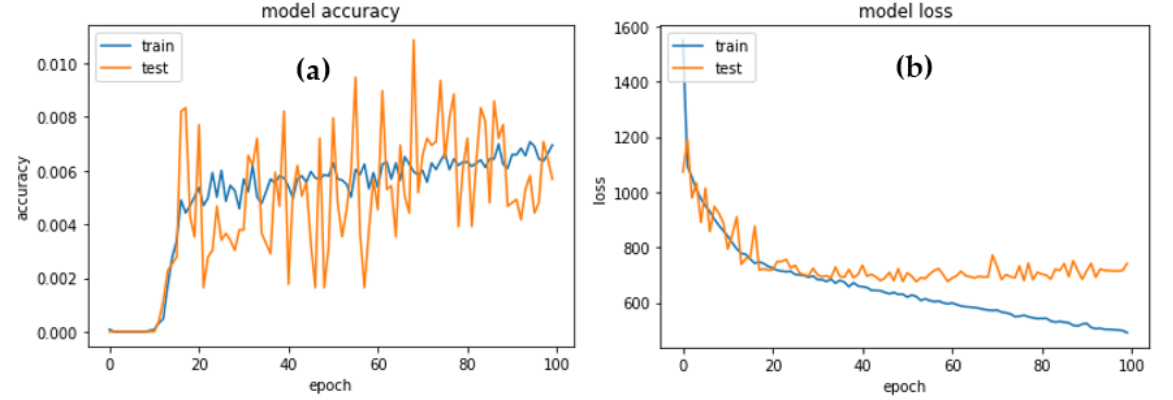
13 of 25 Figure 10. Visual representation of the hypertensive retinopathy images.